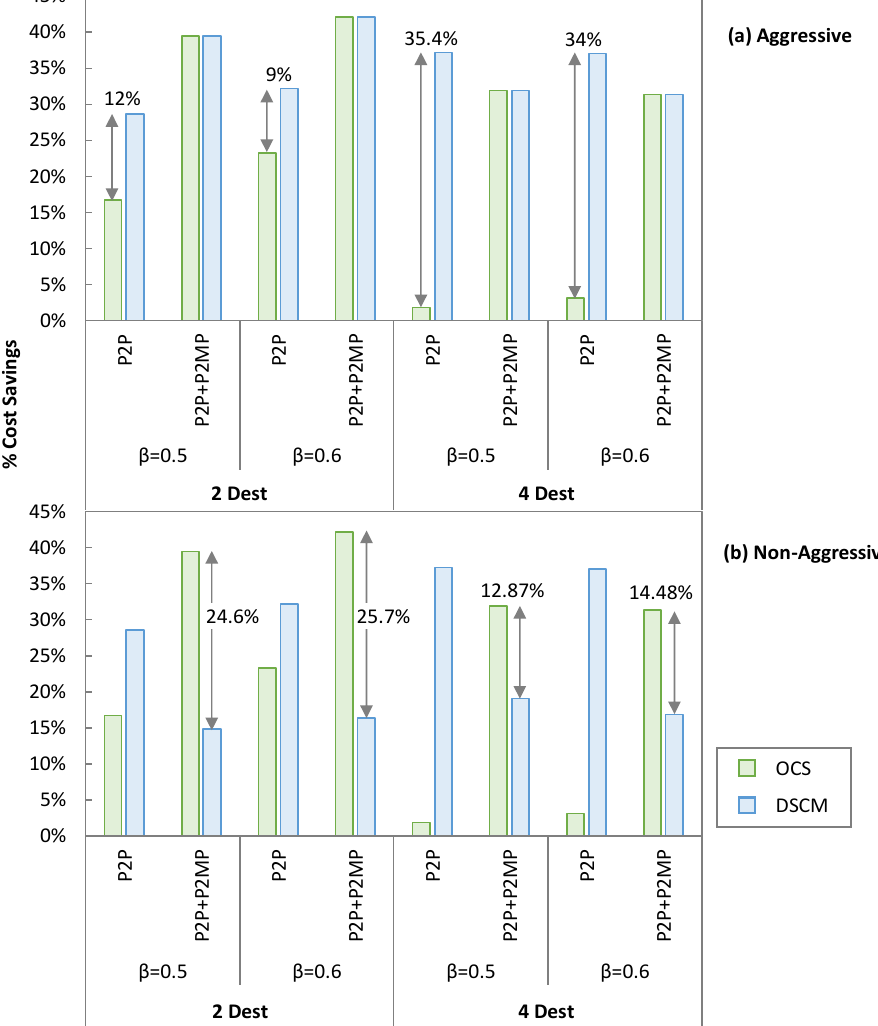
Figure 12. Cost savings: aggressive approach ( a ) and non-aggressive approach ( b ).